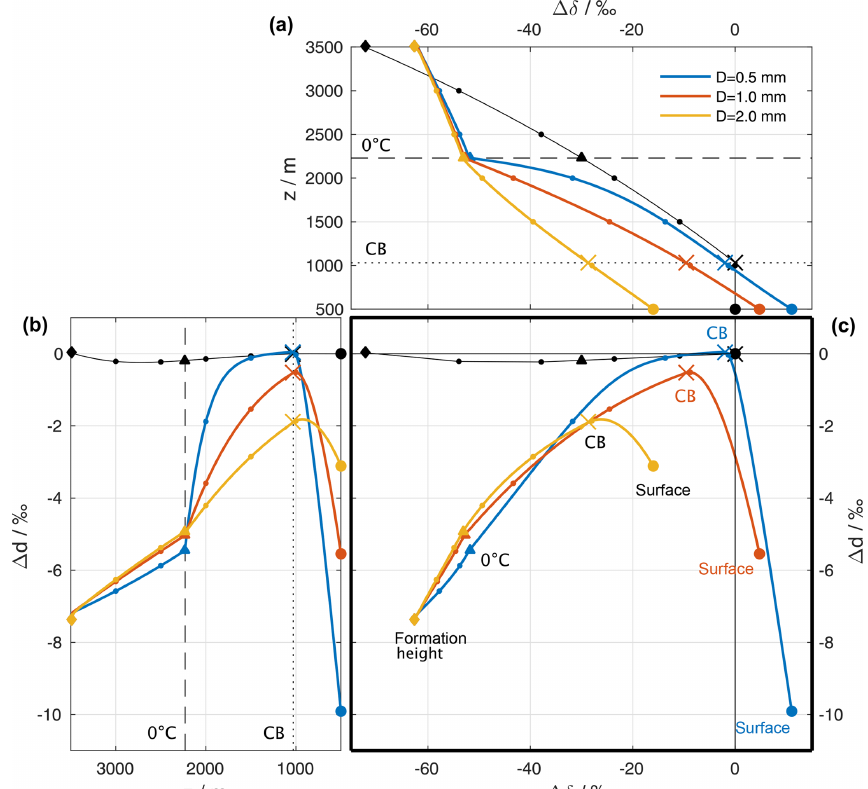
Figure 5. Isotopic composition of the hydrometeors and the surrounding vapour of a reference simulation (see Sect. 4). (a) Difference between the surface vapour and the equilibrium vapour from a falling liquid hydrometeor ( (cid:49)δ , coloured lines). The composition of the ambient vapour at different altitudes relative to surface vapour ( δ 2 H v − δ 2 H v , 0 ) is shown as black lines. The curves are similar to the coloured lines in Fig. 4c, but instead of the absolute value showing the deviation from the surface vapour composition. The horizontal dashed and dotted black lines mark the height of the 0 ◦ C isotherm and the height of the cloud base (CB), respectively. (b) Same as (a) , but for d p and d p , eq and rotated to match the y axis of (c) . (c) (cid:49)δ(cid:49)d -diagram: (cid:49)δ from (a) vs. (cid:49)d from (b) . In all plots, the isotopic composition at every full 500m is highlighted with a small dot. The compositions at the following altitudes are also highlighted: diamond: altitude of release; triangle: altitude of T d = 0 ◦ C; cross: altitude of the cloud base; large filled circle: surface. For simplicity, the equilibrium vapour from a liquid hydrometeor is shown above the 0 ◦ C